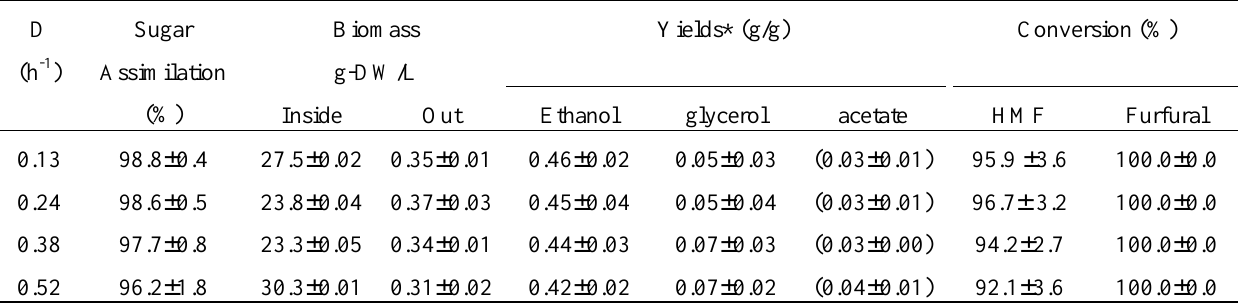
Table 2 . The performance of flocculating yeast in continuous cultivation of dilute-acid hydrolyzate without additional nitrogen source in a single bioreactor equipped with recycling system (Figure 1A) at different dilution